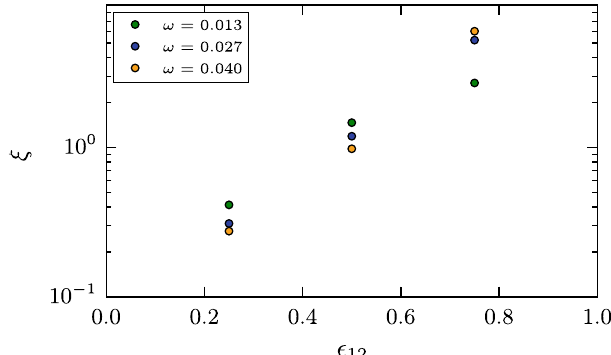
Figure 9. Dependence of the asymmetry length ξ on the intergrain attraction ǫ 12